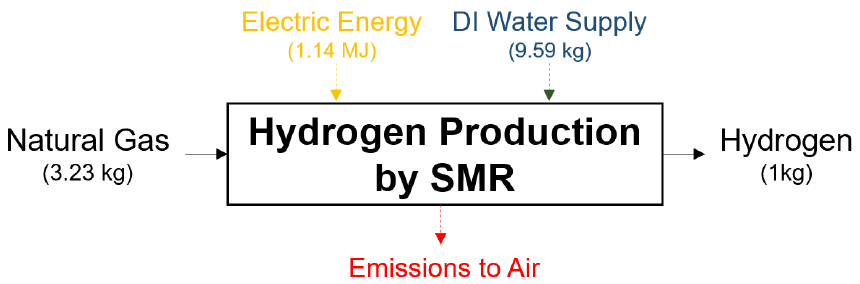
Figure 7. SMR process modeling for hydrogen in the well-to-tank phase.